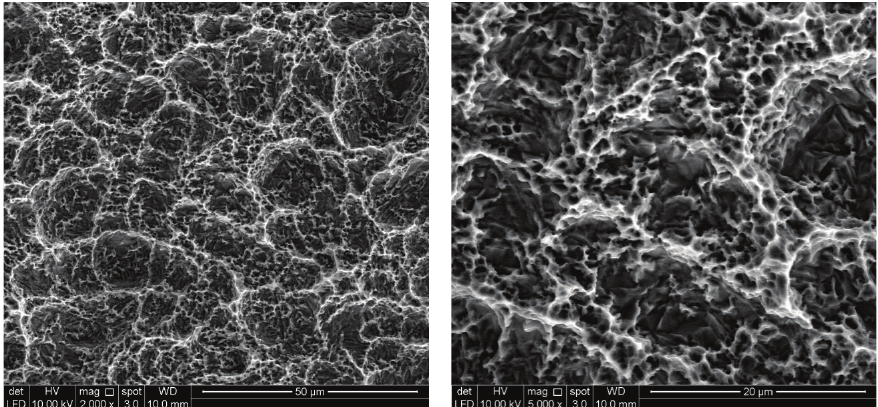
Figure 5: Showing the appearance of the acid etched CPTi samples under the SEM at 2000x and 5000x magnification.